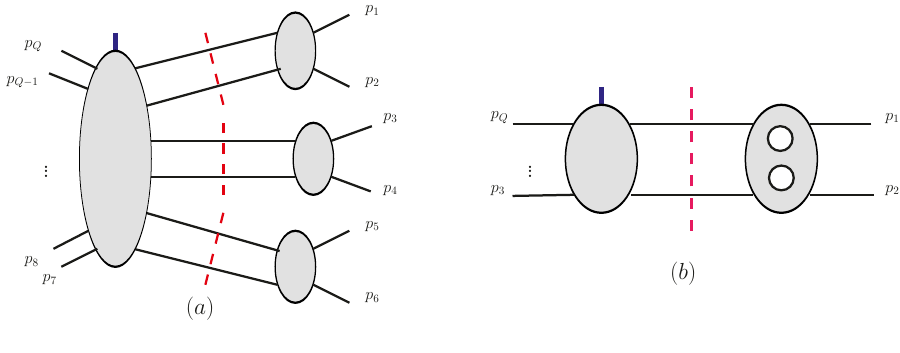
Figure 3 . The cuts corresponding to the last term and the first term in